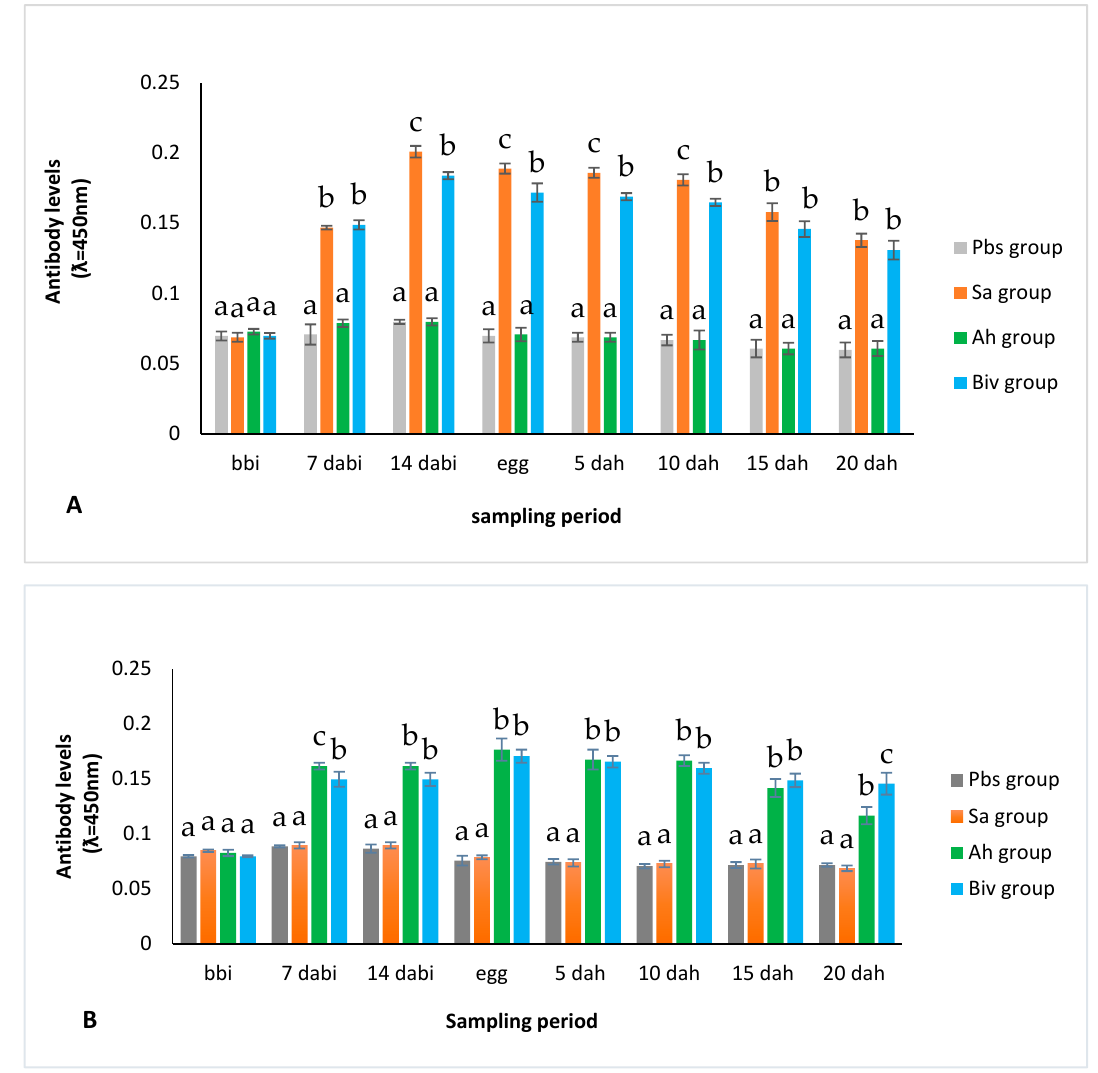
Figure 1. Antibody from tilapia serum zero (before immunization), seven, and 14 days after immunization, egg homogenates and larva homogenates aged 5, 10, 15, and 20 days after hatching against S. agalactiae antigens coating ( A ) and A. hydrophila antigens coating ( B ). Different superscript letters in the same sampling period showed significantly different immunization effects (Duncan’s test: p < 0.05), bbi: before broodstock immunization, dah: days after hatch, Pbs: phosphate buffered saline, λ : optical density, dabi: days after broodstock immunization.